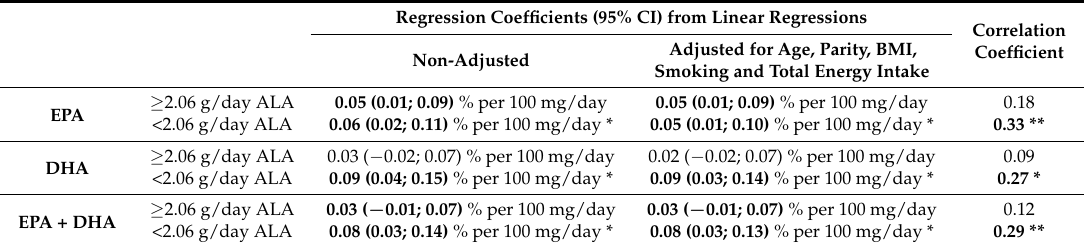
Table 3. Difference in biomarker concentration (%TPFA) per increase in daily intake and correlations between biomarker concentration and intake from Spearman statistics unless indicated